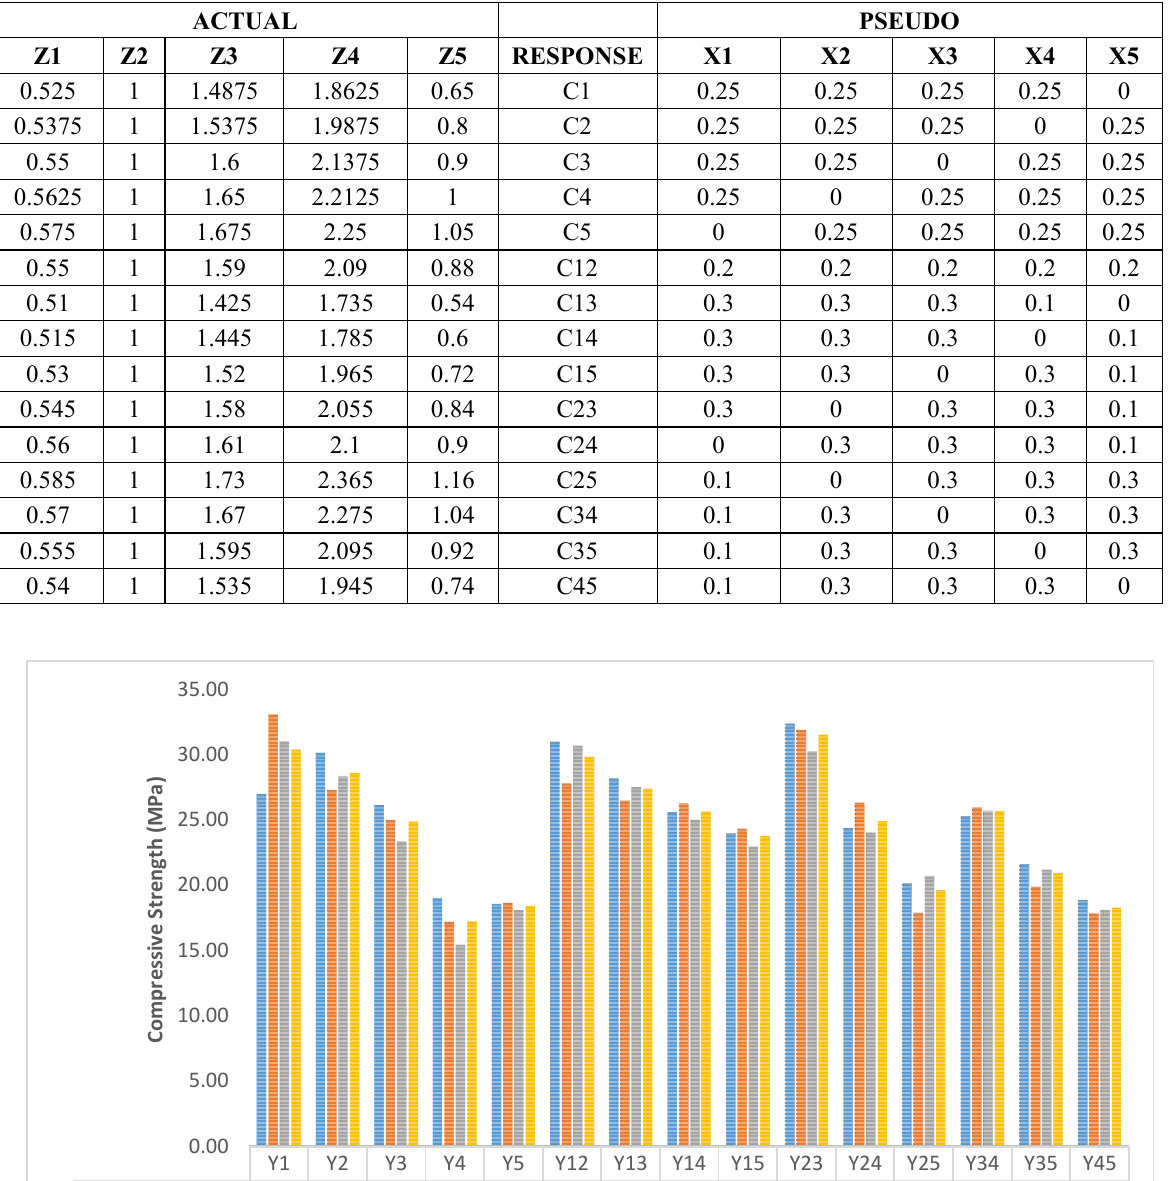
Mixture Proportion of Control Points for Compressive Strength Test.